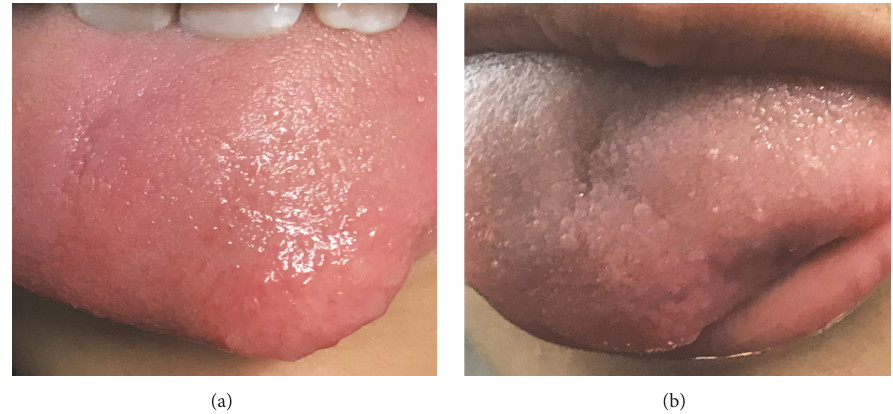
Figure 1: (a) Well circumscribed, 2 cm mass on left anterior tip of the tongue. (b) Tongue after excision of the mass.